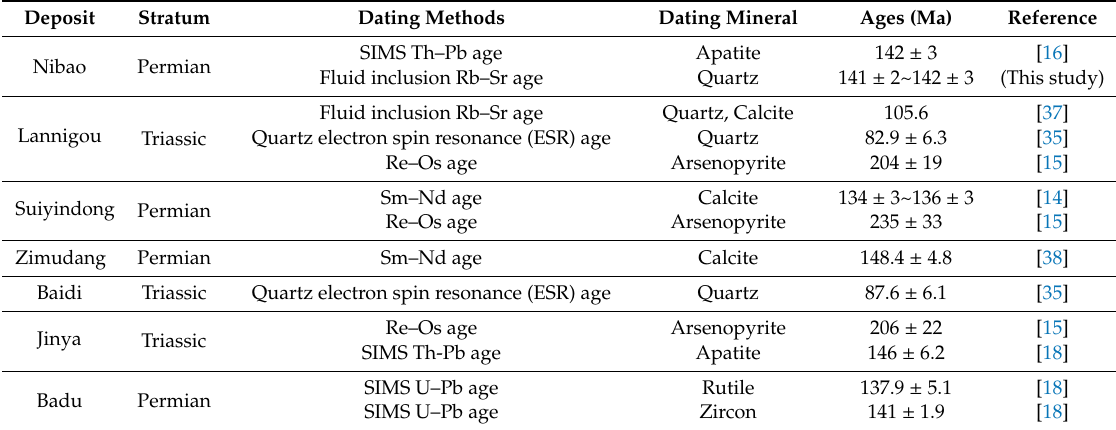
Table 2. The ages of typical gold deposits in the Golden Triangle